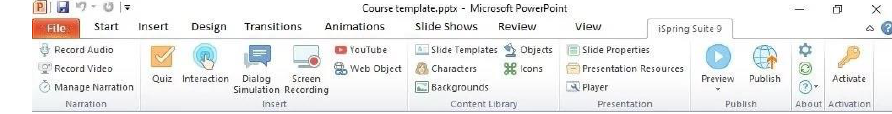
Fig. 2. ISpring control panel integrated in MS